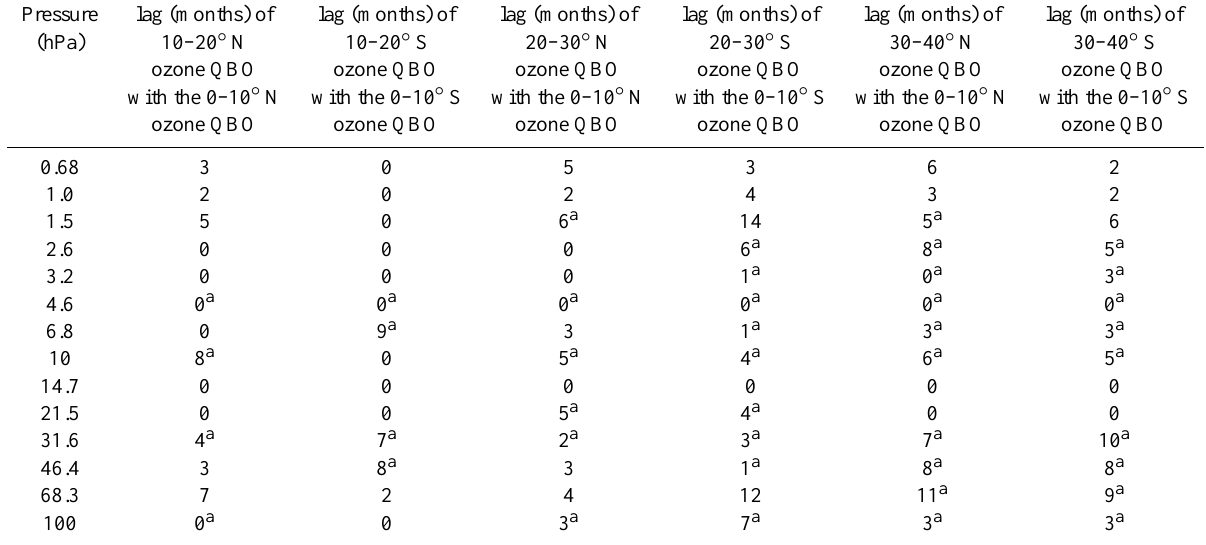
Table 3. Vertical variation of lag correlation of ozone QBO over the equatorial belt (0–10N–S) with ozone QBO at different latitudinal belts.